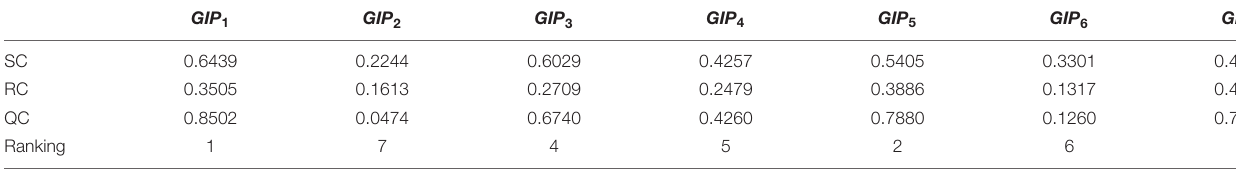
TABLE 11 | The niche-fitness of academic research institutes.